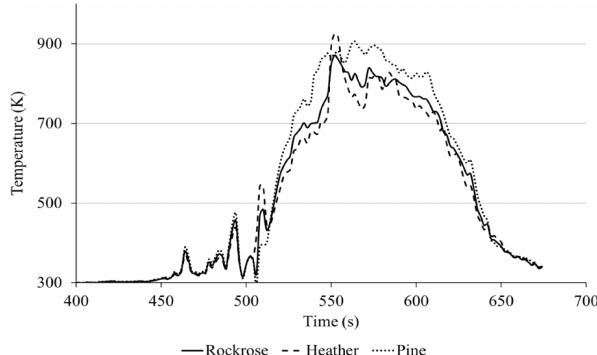
Figure 6. Average temperature vs. time obtained during a field ex-